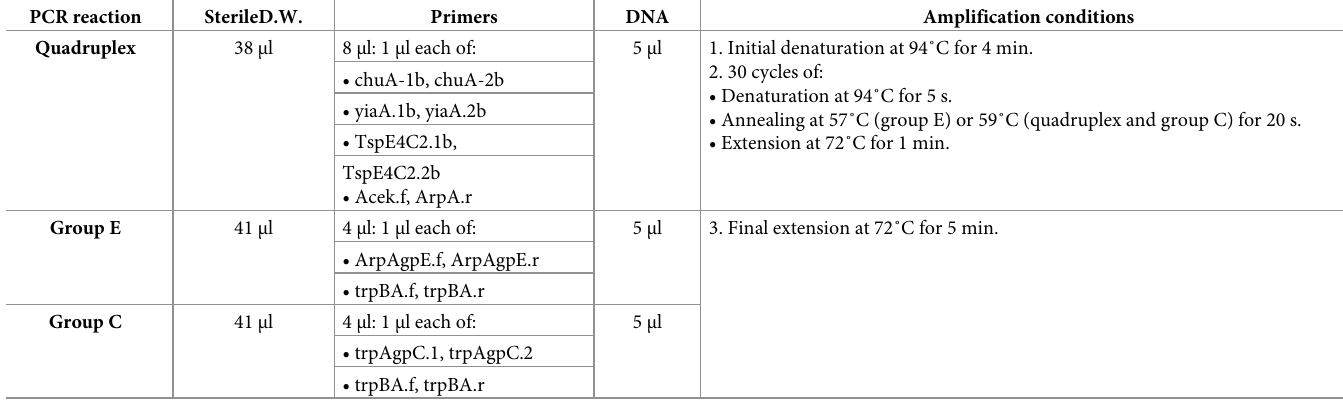
Table 2. Components of 50 μ l PCR master mix and amplification conditions for detection of UPEC phylogroups [17]. PCR